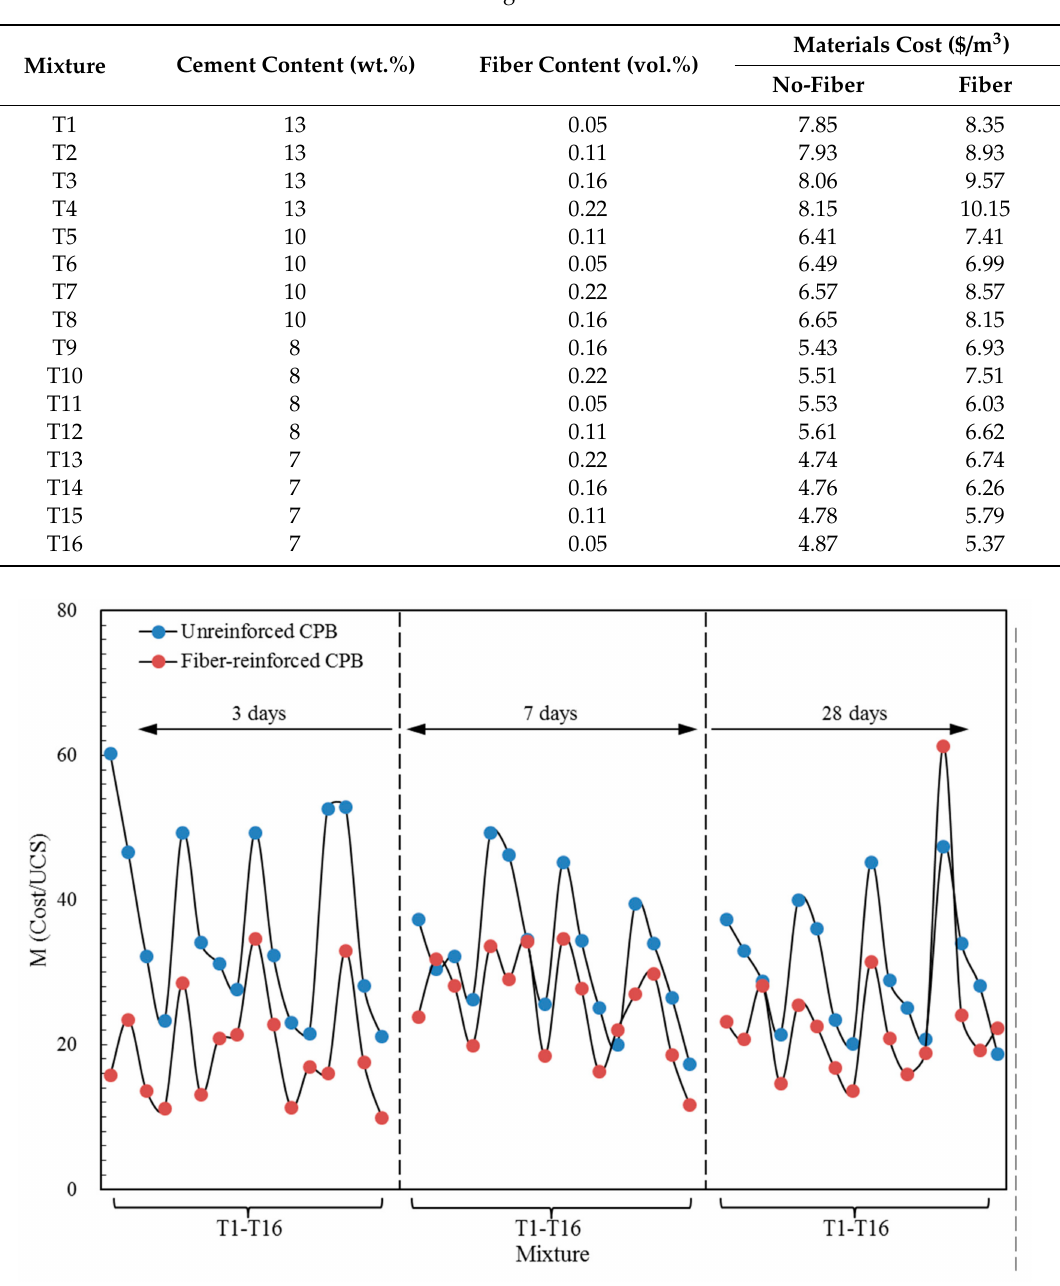
Figure 13. The ratio of materials cost to UCS of